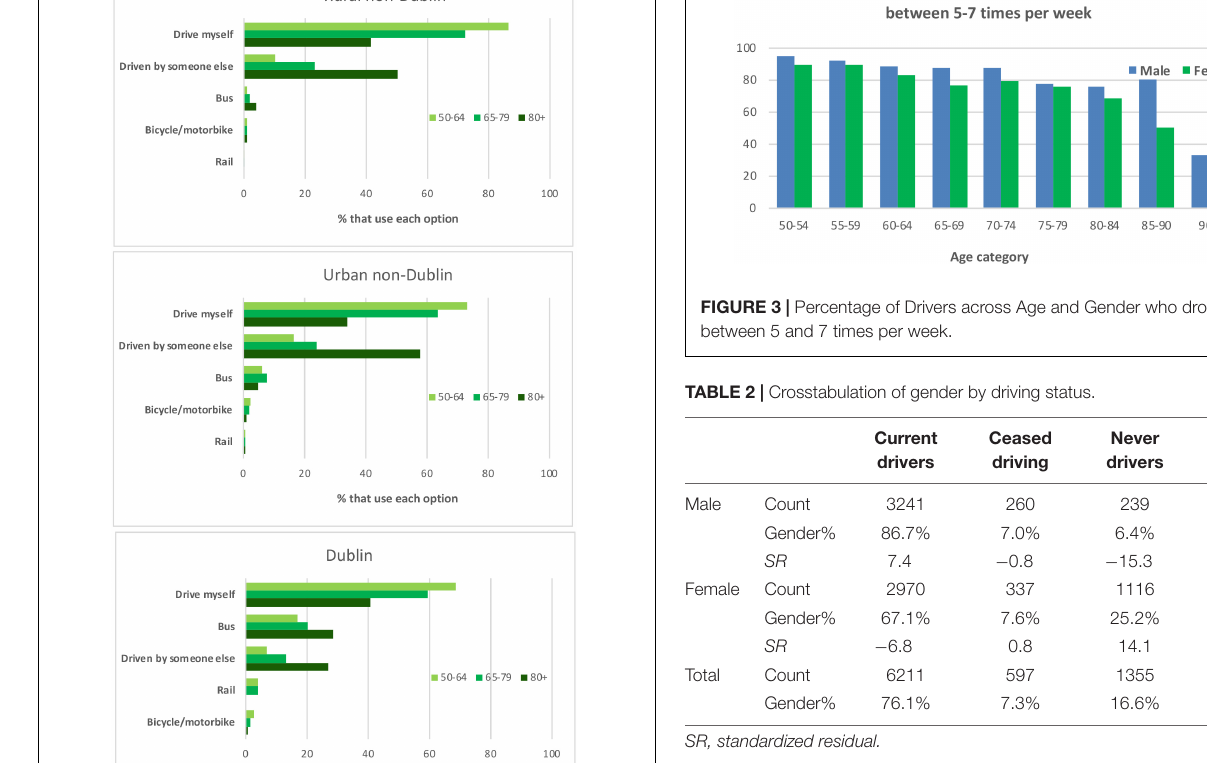
was distributed across Married participants. For Married Males there was a higher than expected number of Drivers (SR = 2.9)